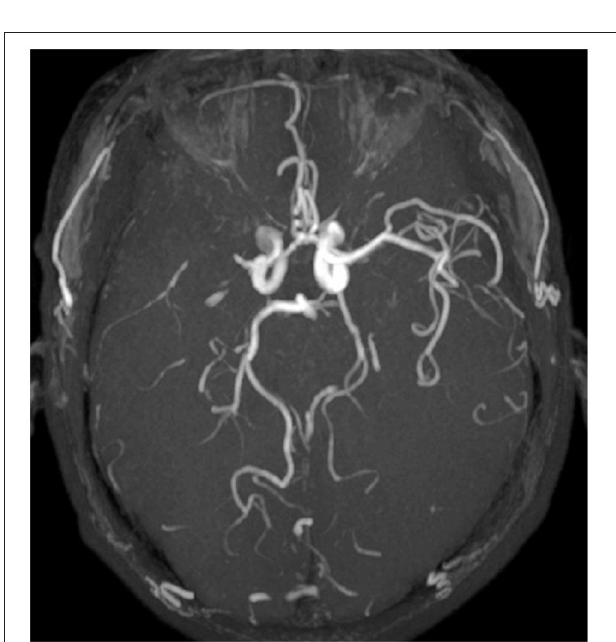
FIGURE 2 | Images illustrating prominent laterality posterior (PLPCA) and anterior (PLACA) cerebral arteries: M1 segment of right middle cerebral artery occluded, right posterior cerebral artery dilated, and P4 segment visible, with visible P3 segment of left posterior cerebral artery (PLPCA); and greater visibility of right anterior cerebral artery vs. distal end of left anterior cerebral artery